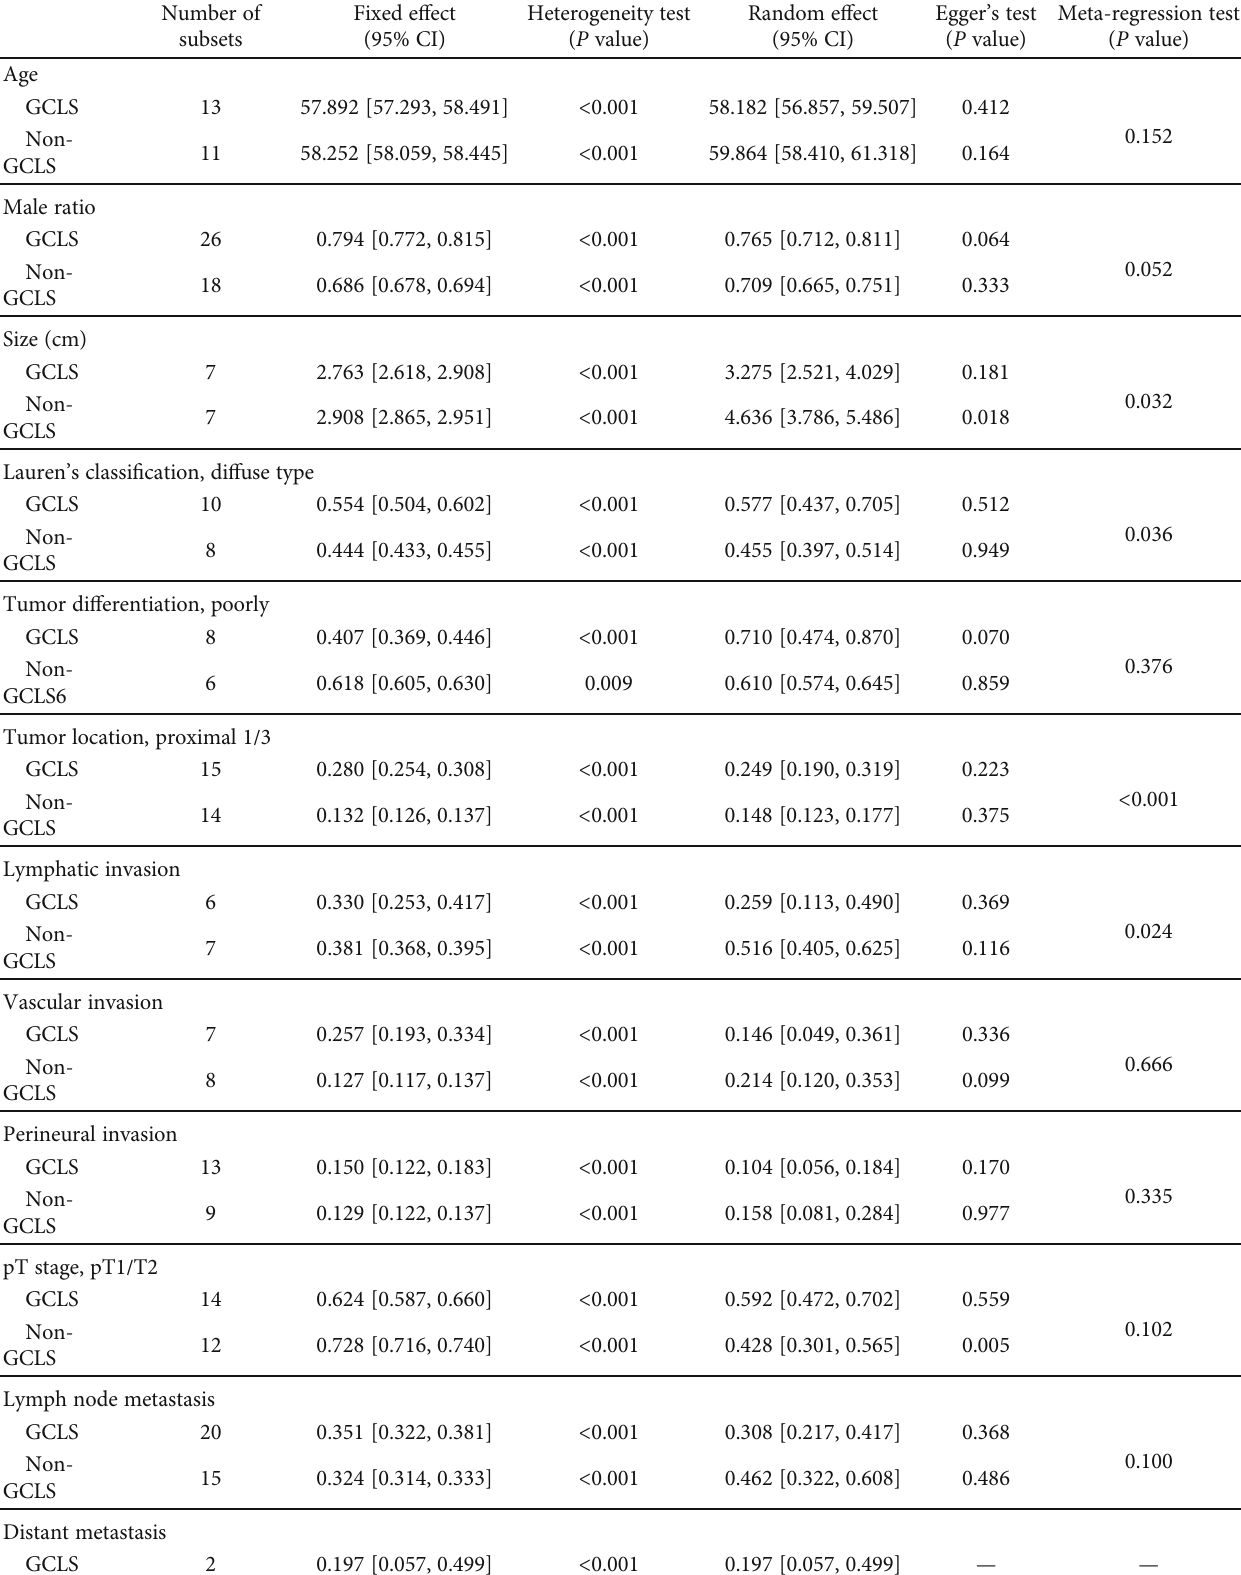
Table 3: Clinicopathological signi fi cances of gastric carcinoma with lymphoid